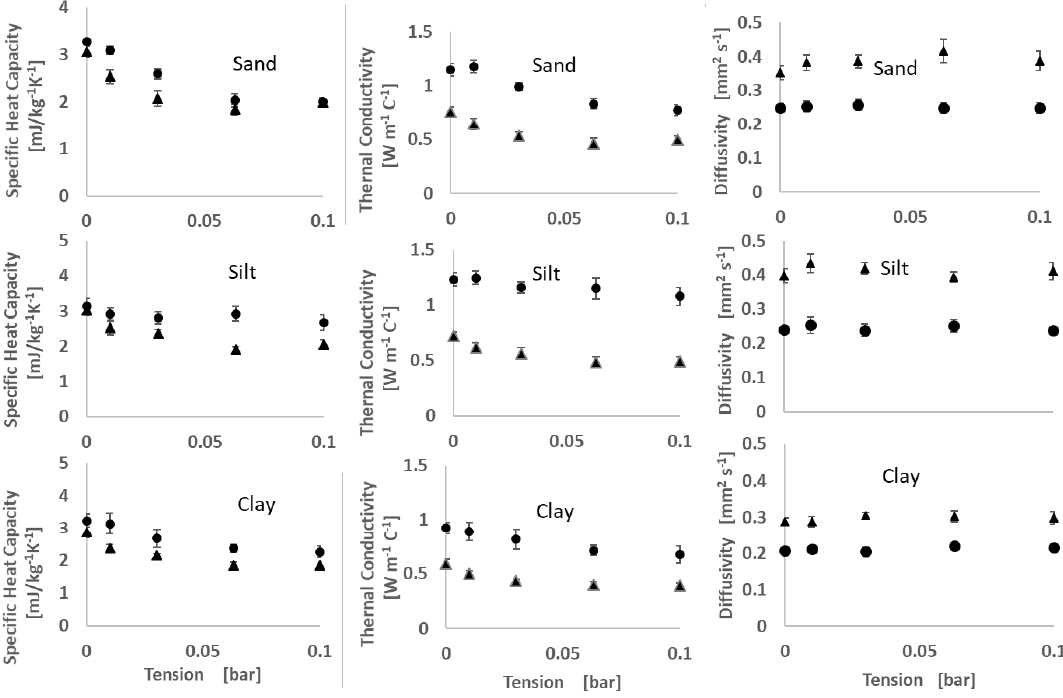
Figure 3. Thermal properties for the three soils for CAST (circles) and NOCAST (triangles) soils. Error bars represent 1 standard error.